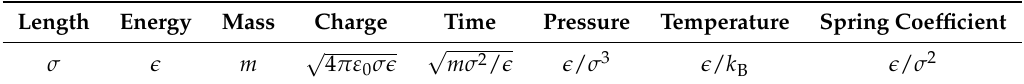
Figure 1. ( a ) The three polymer charge sequence types considered in this work. Each green bead carries a single positive charge q . ( b , c ) Equilibrium 3D orthographic snapshots at a nanoparticle (NP) volume fraction of φ ≈ 37%. ( b ) Non-dispersed system of end-charged N = 40 chains, and ( c ) dispersed system of periodic p3-charged N = 100 chains. The former system ( b ) consists of 27 NPs and 270 chains in a simulation box with dimensions of 27.6 × 27.6 × 27.6, and the latter ( c ) of 36 NPs, 144 chains in a simulation box of the size 30.34 × 30.34 × 30.34. Green spheres show positively charged monomers, and purple spheres the negatively charged NP surface beads. Neutral NP surface beads and monomers are shown by yellow and (small) red spheres respectively. Bond connections between successive monomers within the chains are shown by red cylinders. Table 1. Lennard–Jones (LJ) units (first four columns), and derived units (remaining columns) used in this manuscript. The constant ε 0 denotes the vacuum electric permittivity, k B is Boltzmann’s constant, and m the mass of a single monomer